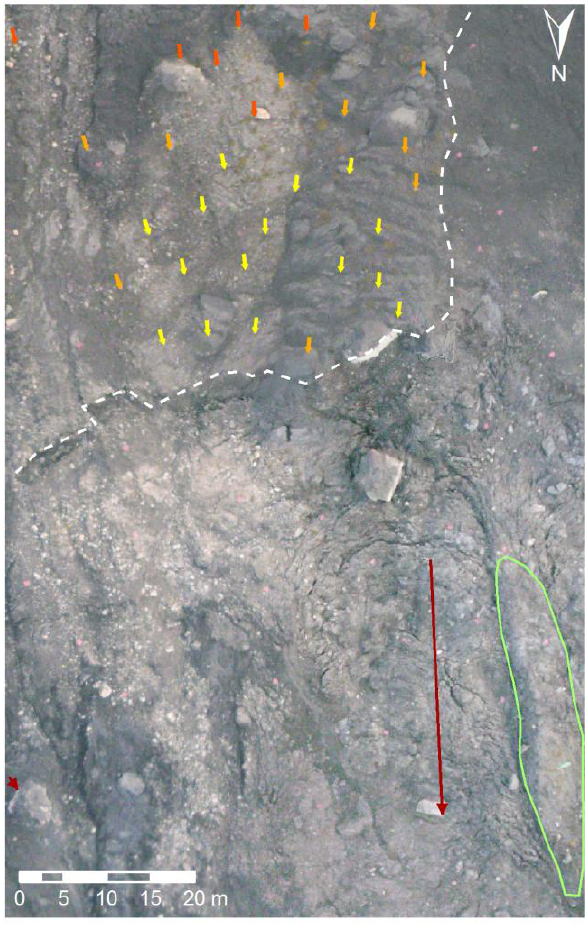
Figure 8. Horizontal displacements and scarp within the Super- Sauze landslide in October